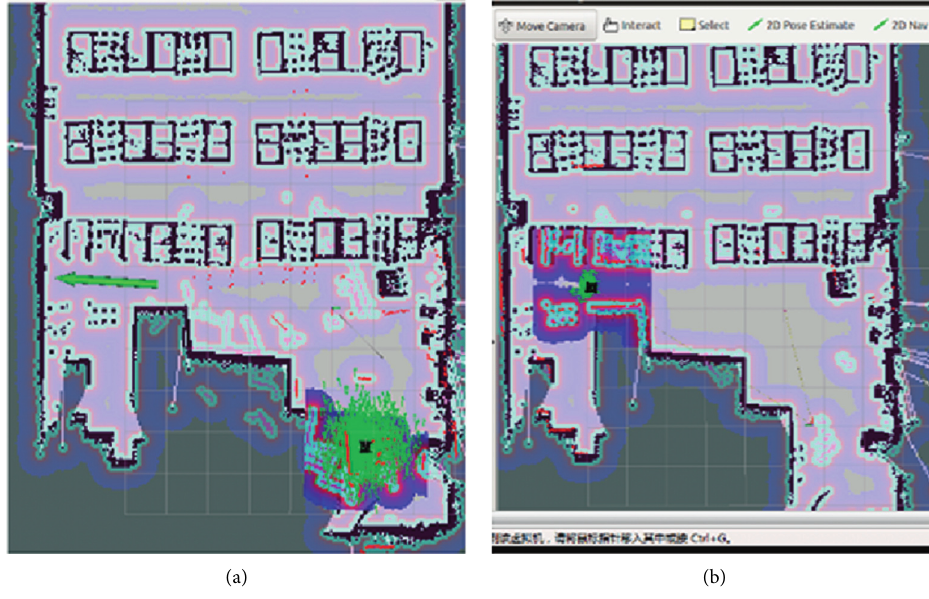
Figure 13: Path planning for lab